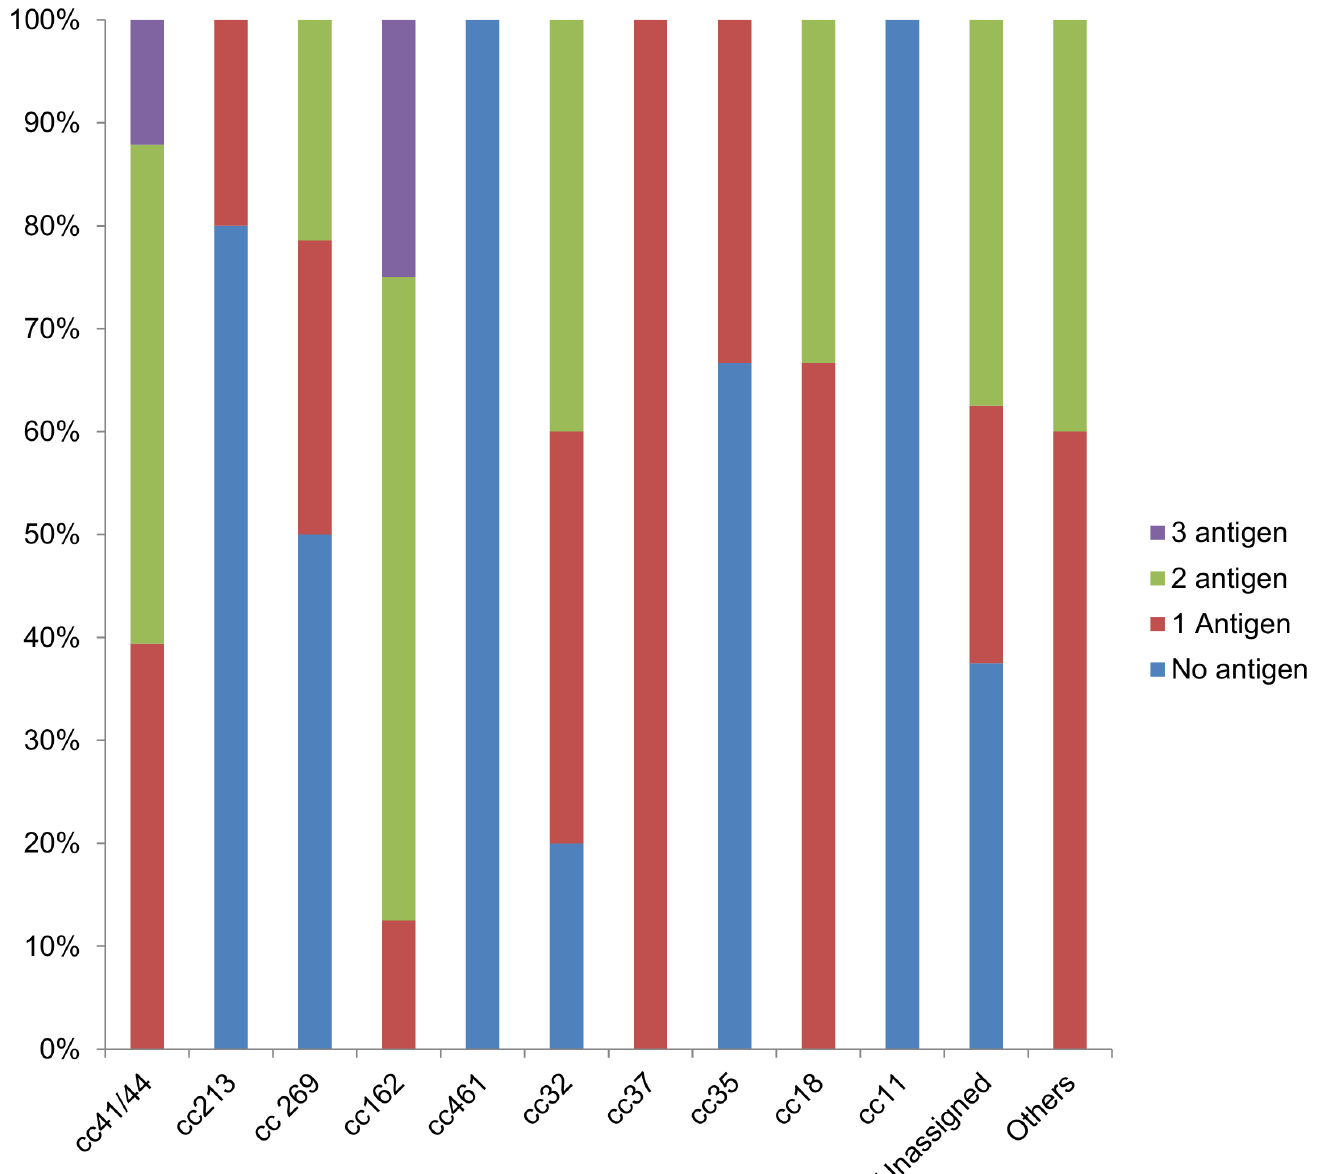
Fig 1. Proportion of strains predicted by MATS to be coveredcontaining one or multiple vaccine antigens and strains not covered, within each clonal complex.